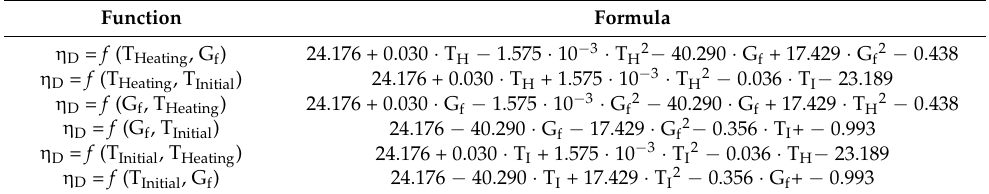
Table 3. Summary of the obtained functions approximating the object functions.